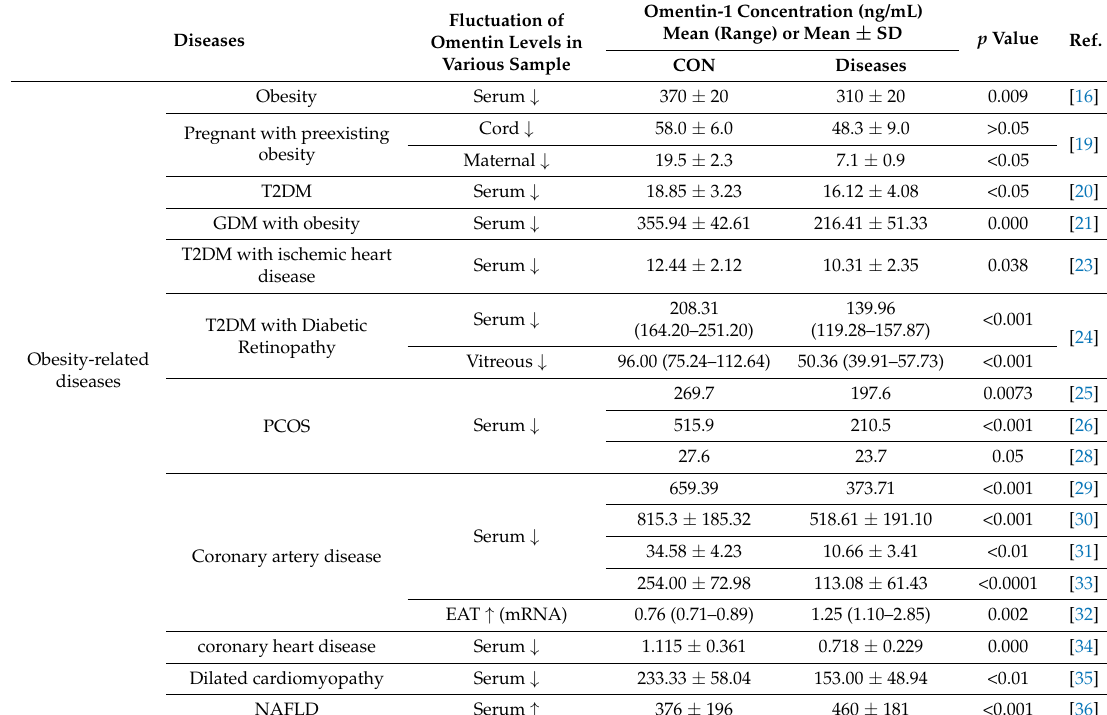
Table 1. Fluctuation of omentin levels in various